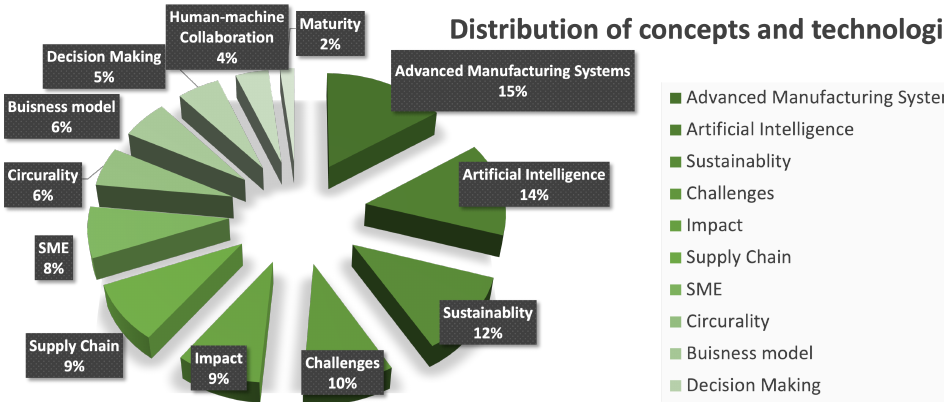
Figure 3. The figure presents the occurrence of the technologies and research fields within the 59 reviewed